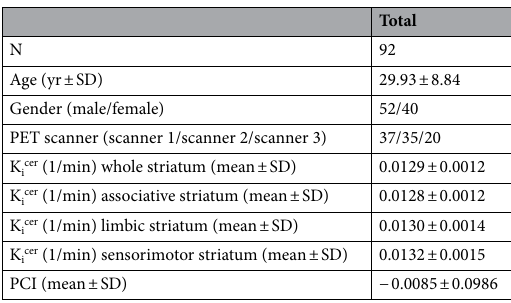
Table 1. Demographic characteristics of the